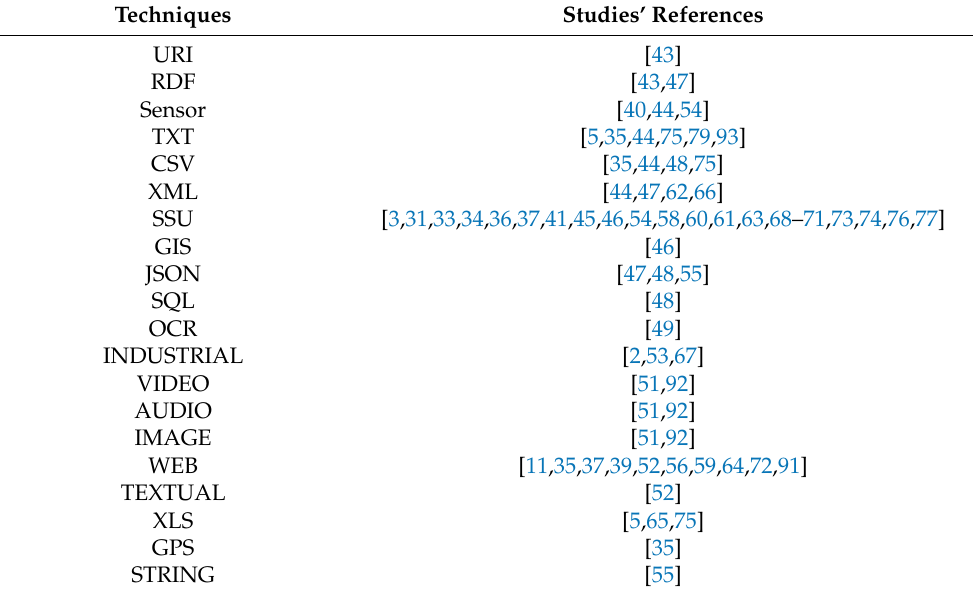
Table 11. Data formats.